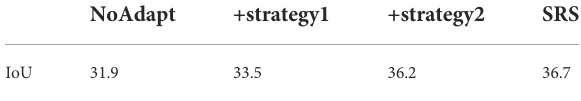
TABLE 3 Ablation experiments of